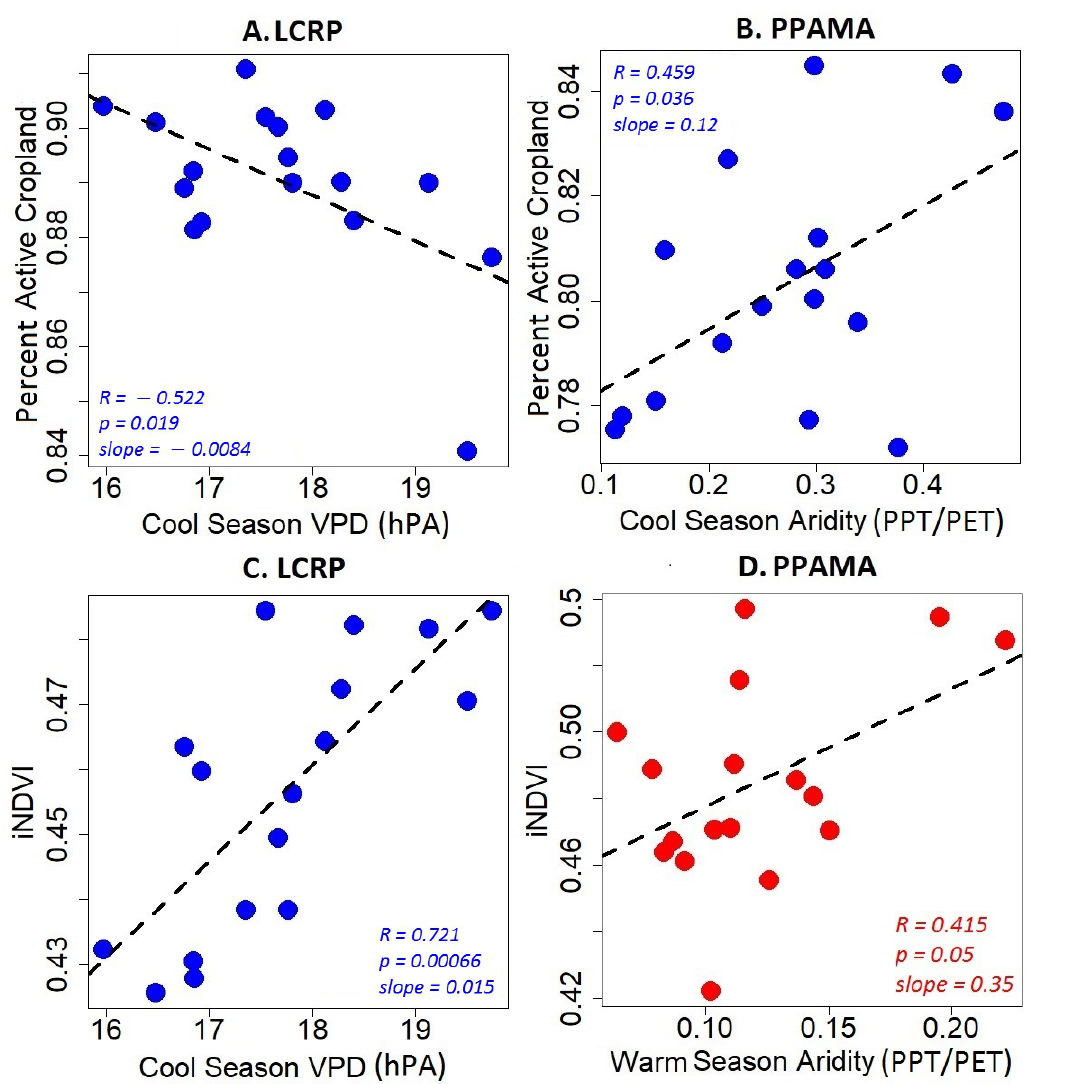
Figure 4. The relationship between key climate factors and active cropland extent and productivity (iNDVI) from 2001 to 2017. LCRP active cropland extent ( A ) and iNDVI ( C ) were most sensitive to cool-season vapor pressure deficit, whereas PPAMA active cropland extent was most sensitive to mean cool-season aridity ( B ) and PPAMA cropland iNDVI was most sensitive to mean warm-season aridity ( D ). Each point indicates an annual mean estimate from 2001 to 2017. Dashed lines show the linear regression fit of all significant ( p < 0.05) relationships. Blue signifies a relationship with cool-season climate variable while red represents a relationship with warm-season climate